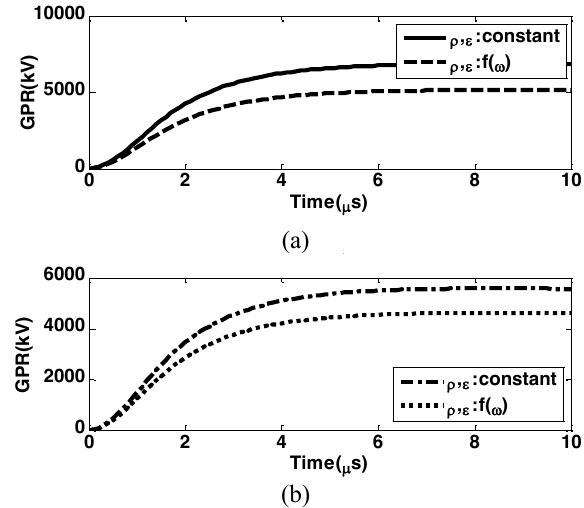
Figure 14: Transient voltage of grounding grid from the first example with two simultaneous injections at (a): port#1 and